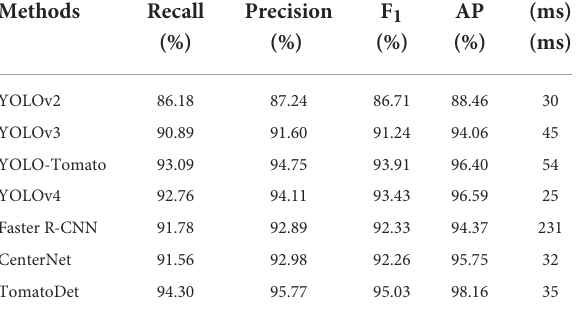
TABLE 3 Tomato detection results of different algorithms.